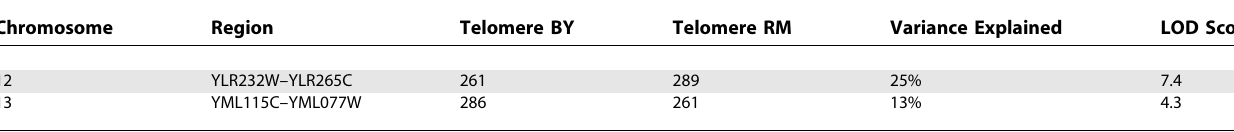
Table 2. Loci That Control Telomere Length in RM and BY Strains Chromosome Region Telomere BY Telomere RM Variance Explained LOD Score